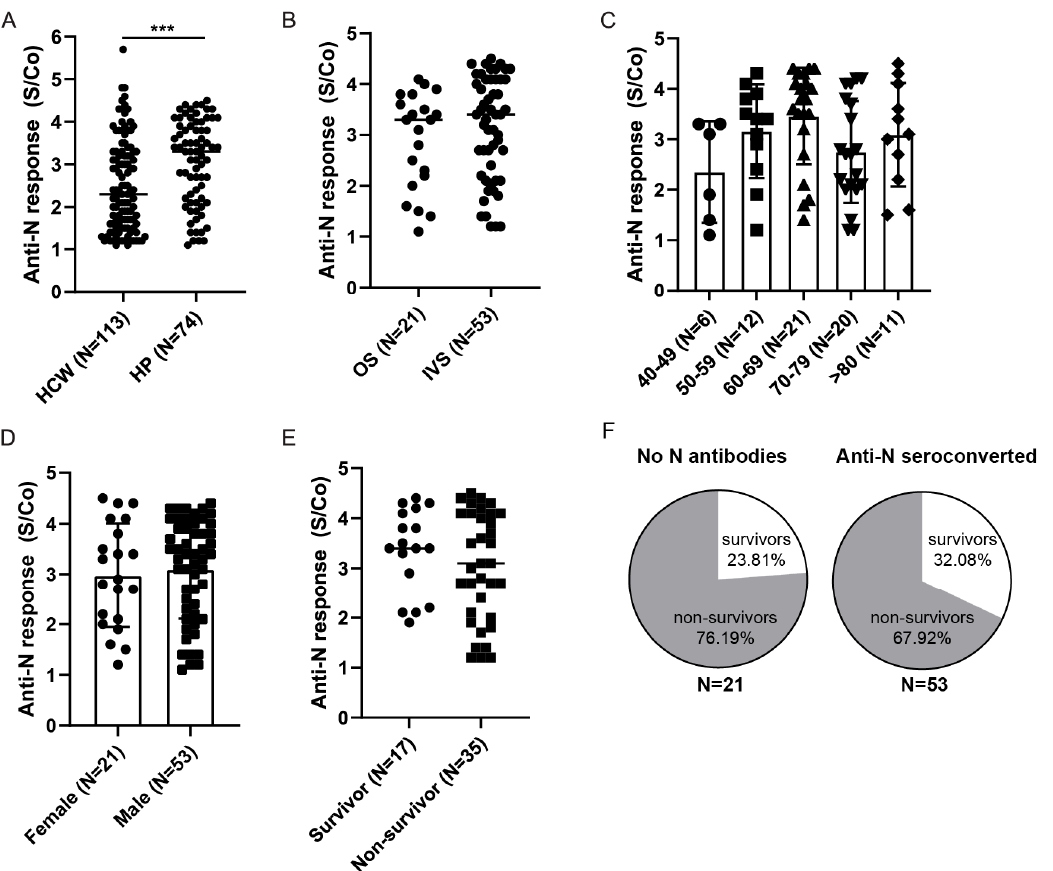
Figure 7. Anti-Nucleocapsid antibody response in HPs. ( A ) Comparison of anti-Nucleocapsid antibody levels between hospitalized patients (HP) and healthcare workers (HCWs) identified prior to vaccination. ( B ) Hospitalized patients were stratified based on the severity of the disease: oxygen supplementation (OS) vs. invasive ventilation support (IVS), ( C ) age, ( D ) gender, or ( E ) outcome for patients on invasive ventilation support. ( F ) Frequencies of survivors and non-survivors in relation to anti-Nucleocapsid seroconversion. Statistical tests: unpaired t -test ( A ), p value *** p < 0.0005. S/Co, Signal to cut-off ratio.